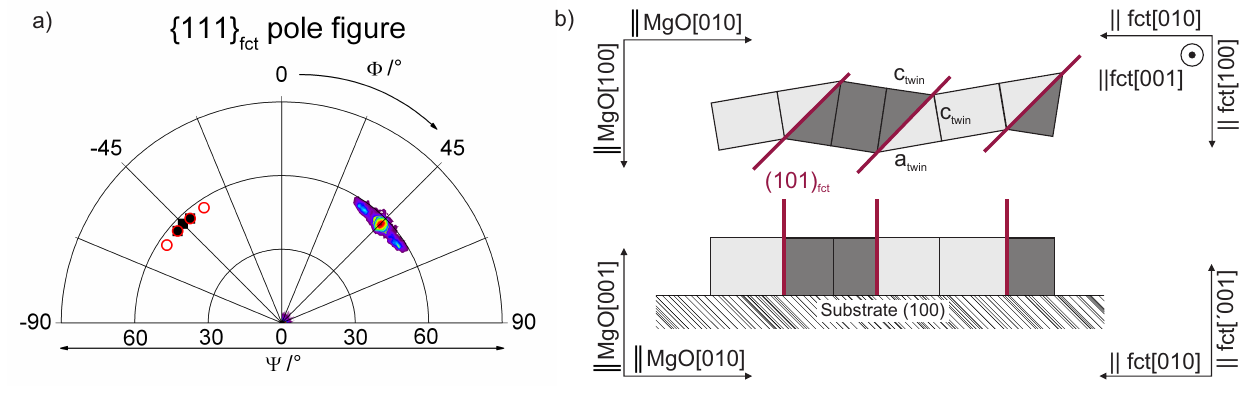
Figure 10. ( a ) Comparison of the measured { 111 } Cu buffer (right quadrant) to a simulation of this pole figure, including { 101 } (left quadrant). Black squares represent the epitaxial matrix and red circles, the first twin generation. ( b ) Schematic sketch for the twin